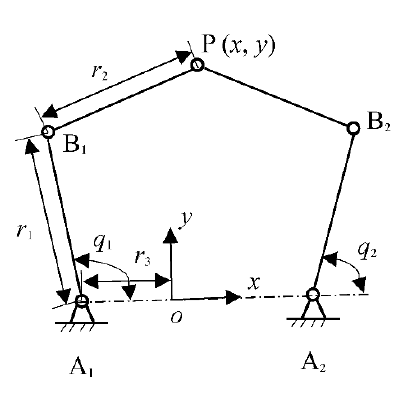
Figure 10. The planar 2-DOF 5R parallel manipulator.